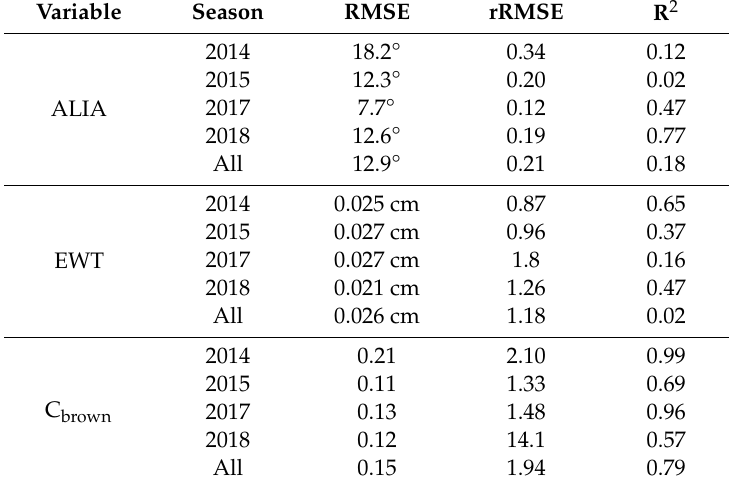
Figure 9. All values of ALIA ( a ), EWT ( b ), C brown ( c ) and Phenology ( d ) for the four winter wheat field campaigns of 2014, 2015, 2017 and 2018. In situ measurements ( a & b ) and estimations ( c ) are shown as solid lines; optimized parameters are drawn with a dashed line style. Table 5. Distance measures between in situ observations of ALIA, EWT and C brown vs. optimized values in the manual fitting process for winter wheat.